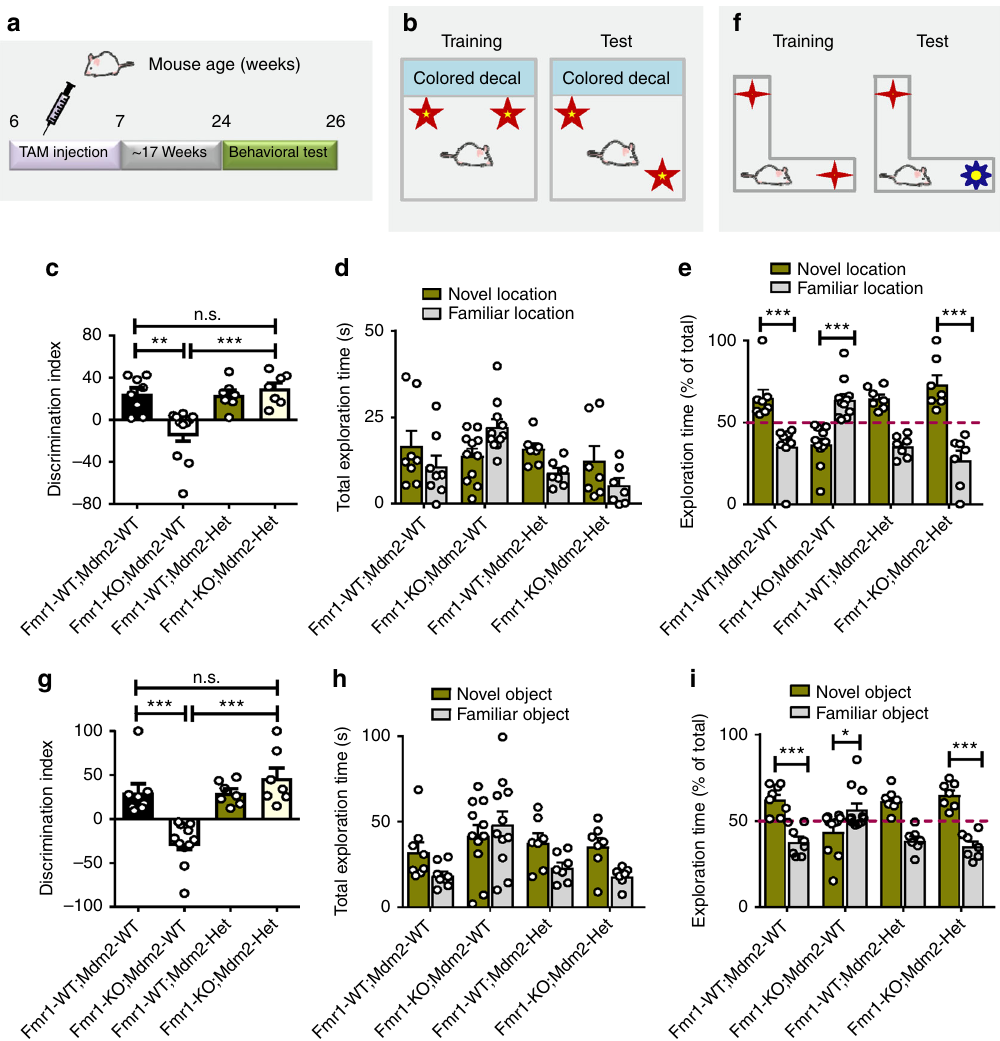
Fig. 8 Heterozygote deletion of MDM2 in Nestin-expressing adult NSCs and new neurons rescues cognitive de fi cits of 6-month-old Fmr1 KO mice. a Experimental scheme for assessing cognitive function transgenic mice followed by TAM injection. b – e Heterozygote deletion of MDM2 in Nestin- expressing adult NSCs and new neurons fully rescues spatial learning de fi cits in Fmr1 KO mice ( n = 7 to 11 mice per group). f – i Heterozygote deletion of MDM2 in Nestin-expressing adult NSCs and new neurons fully rescues novel object recognition in Fmr1 KO mice ( n = 7 to 11 mice per group). * P < 0.05, ** P < 0.01, *** P < 0.001, n.s.: no signi fi cant difference. Two-way ANOVA was used for all data analyses. Data are presented as mean ±